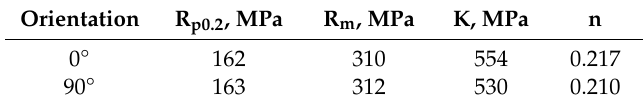
Table 1. Mechanical properties of the deep-drawing quality (DDQ) steel sheet.